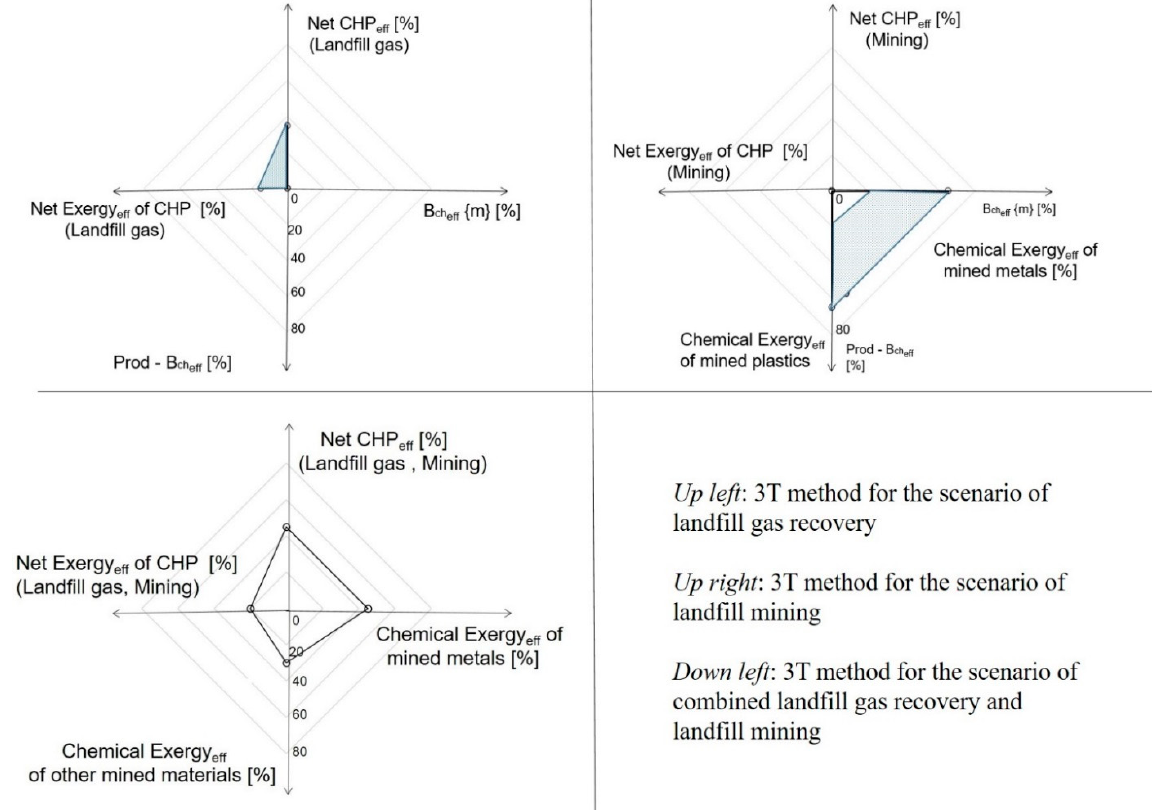
Figure 1. Specific solution of the 3T method for landfilling and landfill gas recovery.